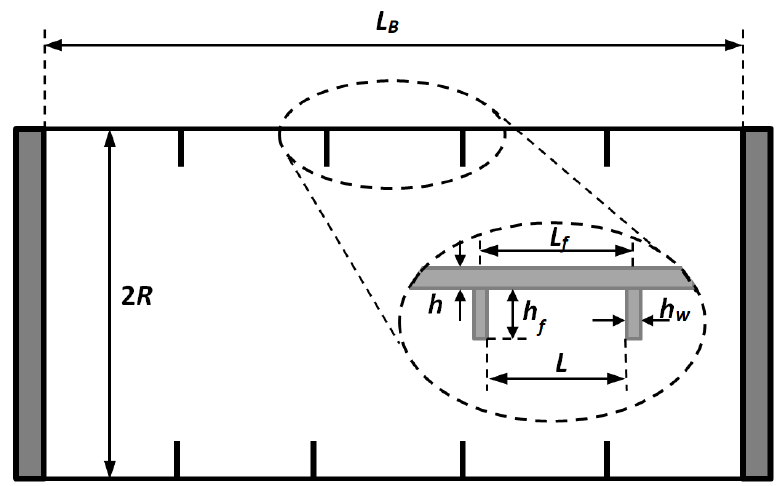
Figure 6. Schematic representation of a cylindrical shell with ring stiffeners. Table 2. Geometry of the conventional stiffened shell.